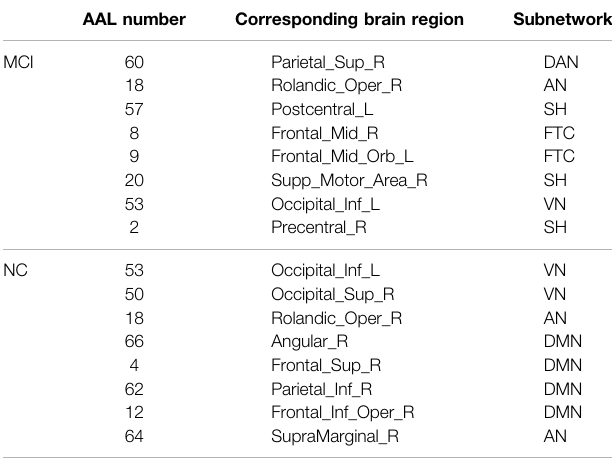
TABLE 3 | Hubs of the MCI and NC groups based on the SR method.